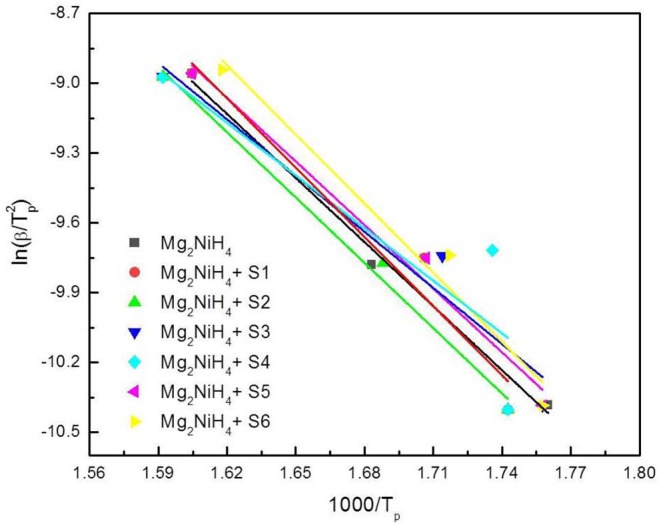
Kissinger's Plot of Mg2NiH4-CeH2.73/CeO2 composite system.